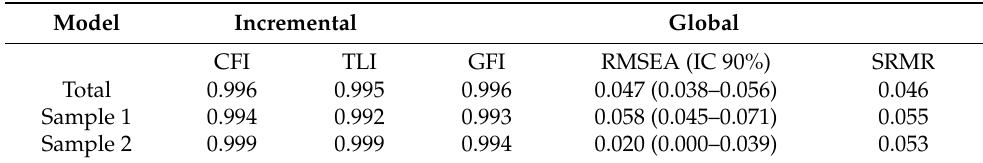
Table 3. Fit indices, confirmatory factor analysis